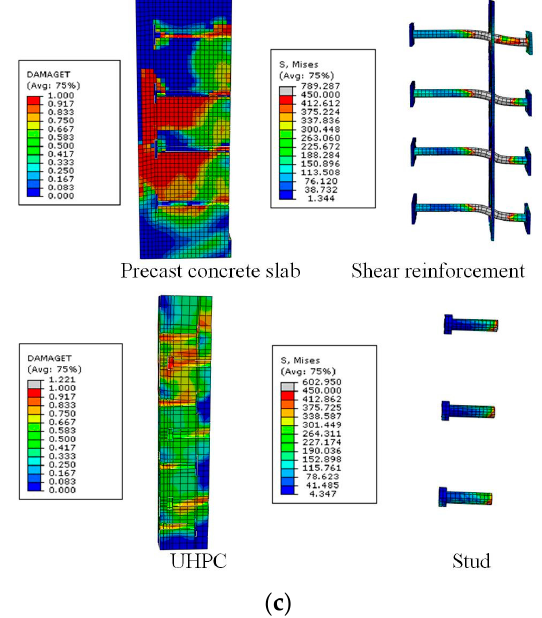
Figure 29. Mises stress distribution: ( a ) 3d; ( b ) 4d; ( c ) 5d.